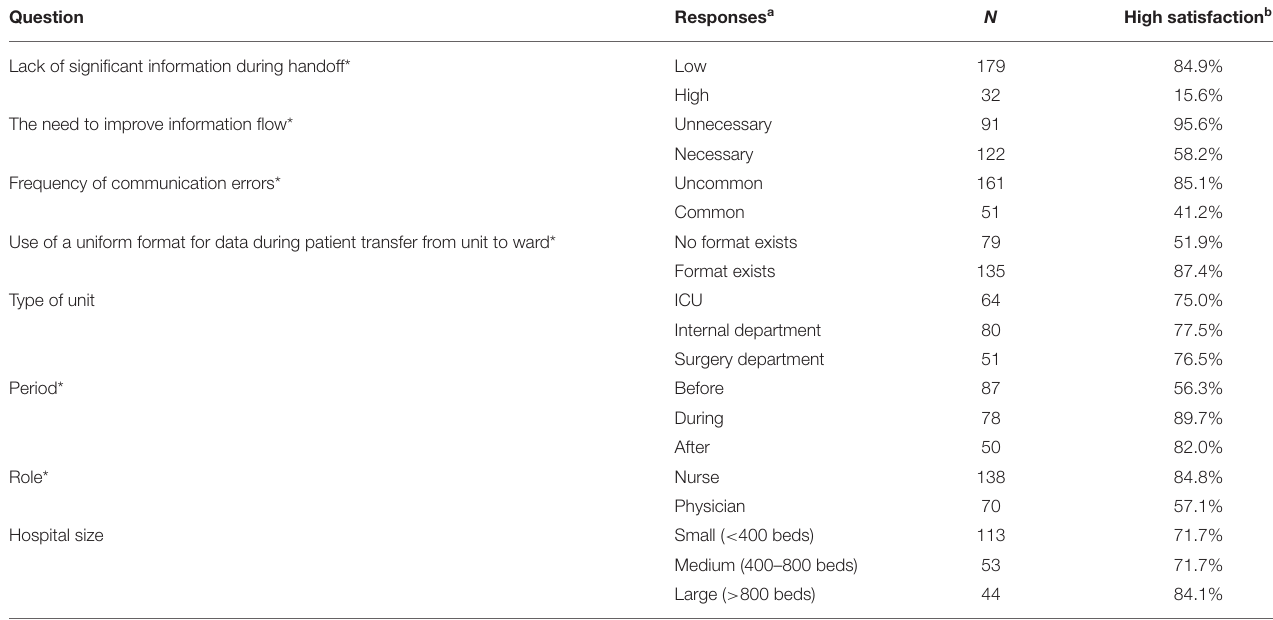
TABLE 3 | Distribution of all respondents during the year of implementation among the various variables correlated with the project satisfaction ( n = 215).